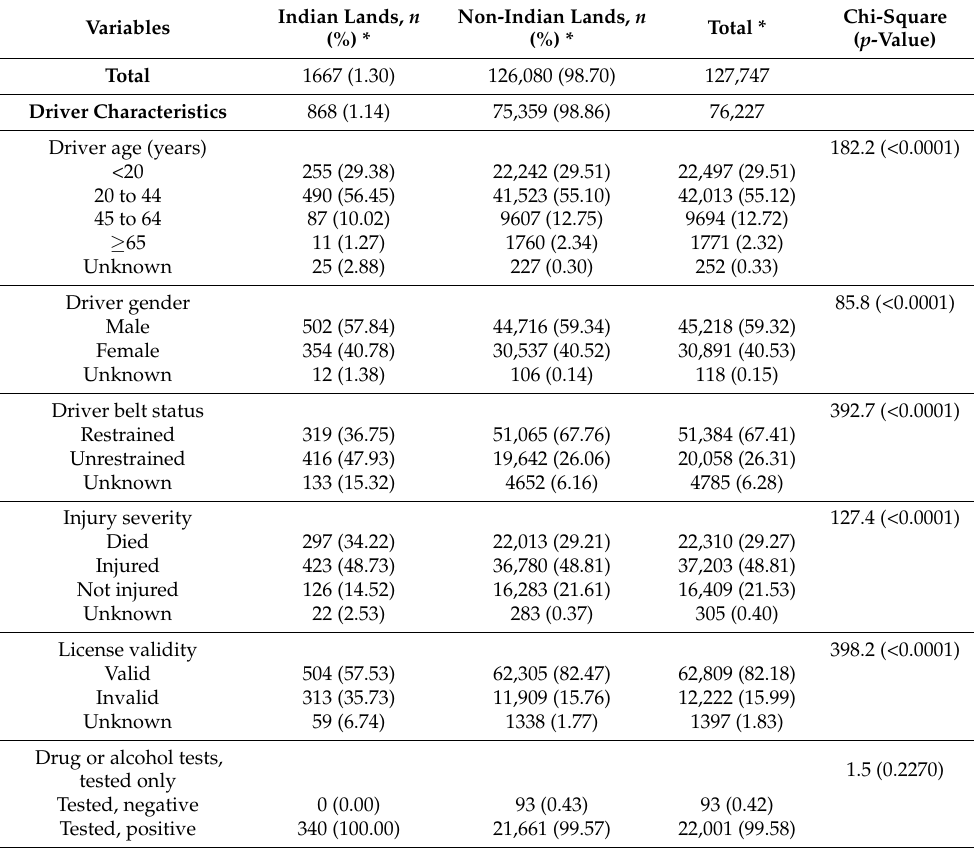
Table 1. Characteristics of crashes on federally recognized Indian lands and non-Indian lands with an infant, child and teen passenger aged 0 to 19 years, FARS